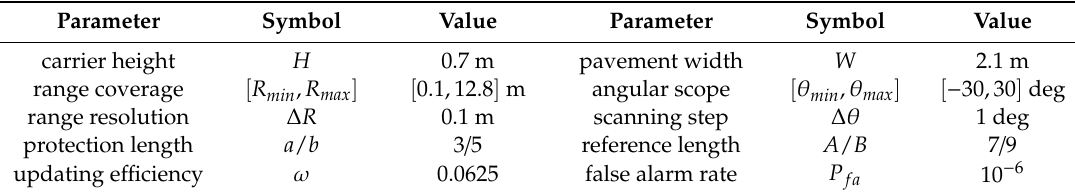
Table 3. Some conditions of cell-averaging (CA-)CM-CFAR.